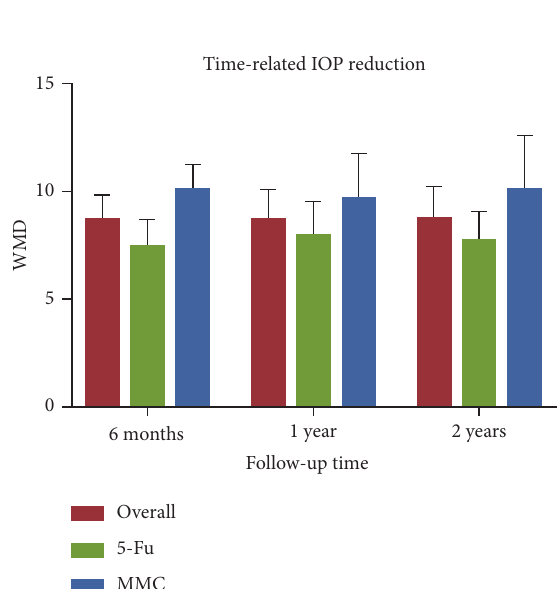
Figure 3: Column graph for time-related IOP reduction: weighted mean difference (WMD) of reduction at different timeline showed stable effects for bleb needling with 5-Fu and